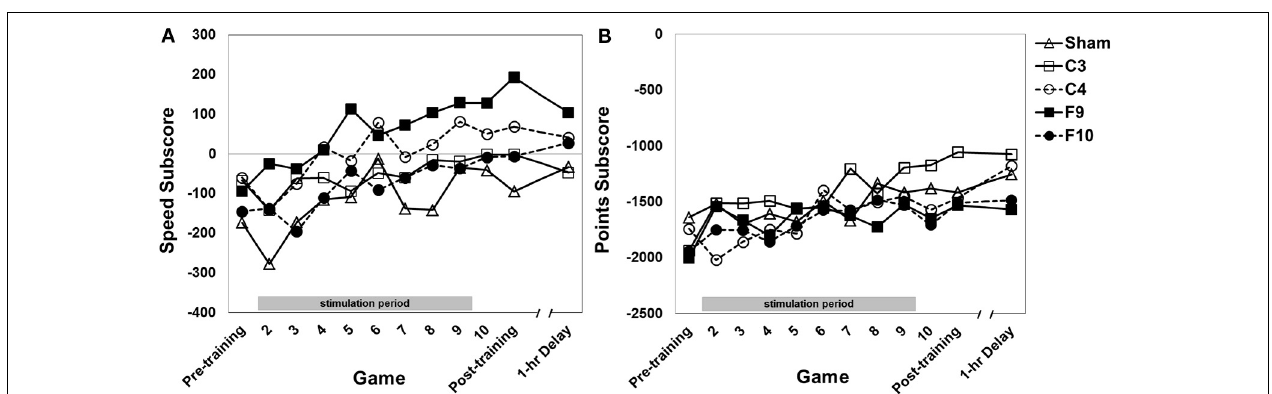
FIGURE 6 | (A) Speed subscore for each stimulation group across 12 games with varying instructional emphasis. (B) Points subscore for each stimulation group across all 12 games with varying instructional emphasis. Pre-training, Post-training and 1-hr Delay games were all “total emphasis” games. The training block consisted of Games 2 through 10. Game 2 was “control score” emphasis, Game 3 was